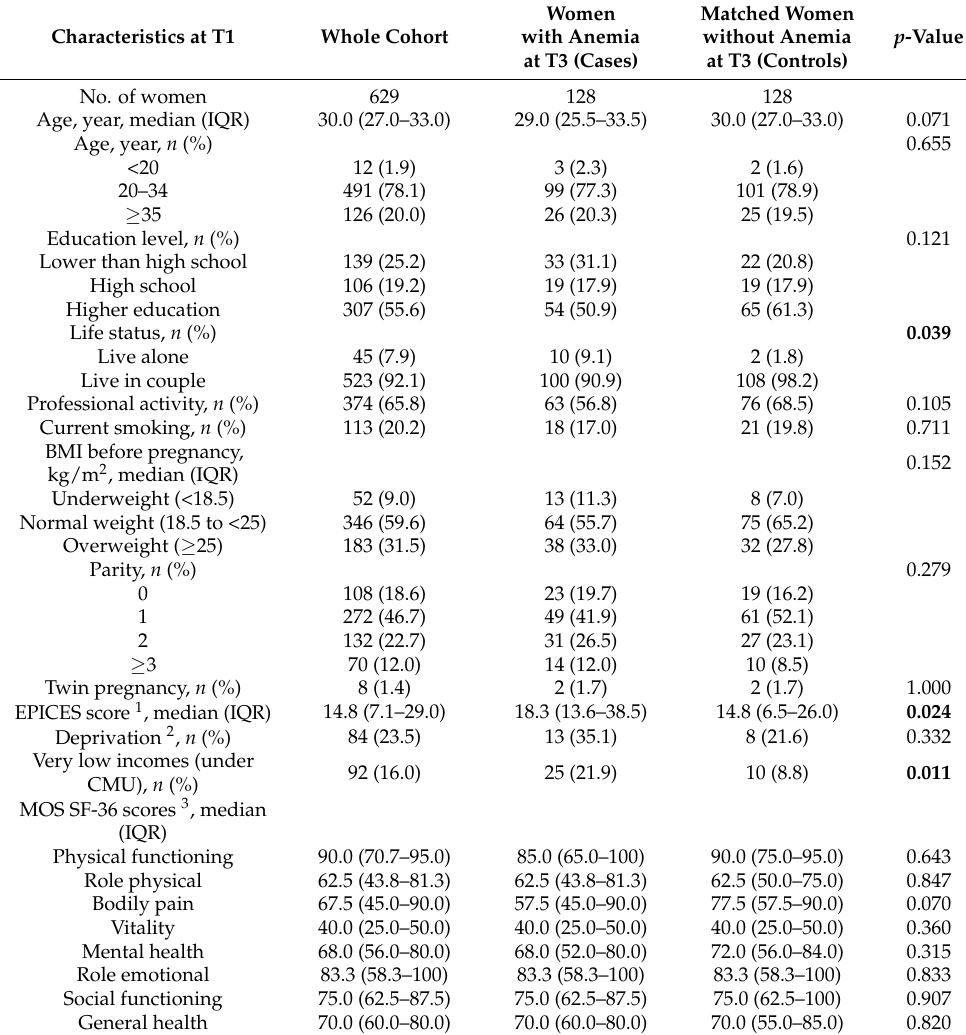
Table 1. Clinical and social characteristics at first trimester of pregnancy (T1) of pregnant women of the whole cohort, women with anemia at third trimester of pregnancy (T3) (cases) and women without anemia at T3 (controls).